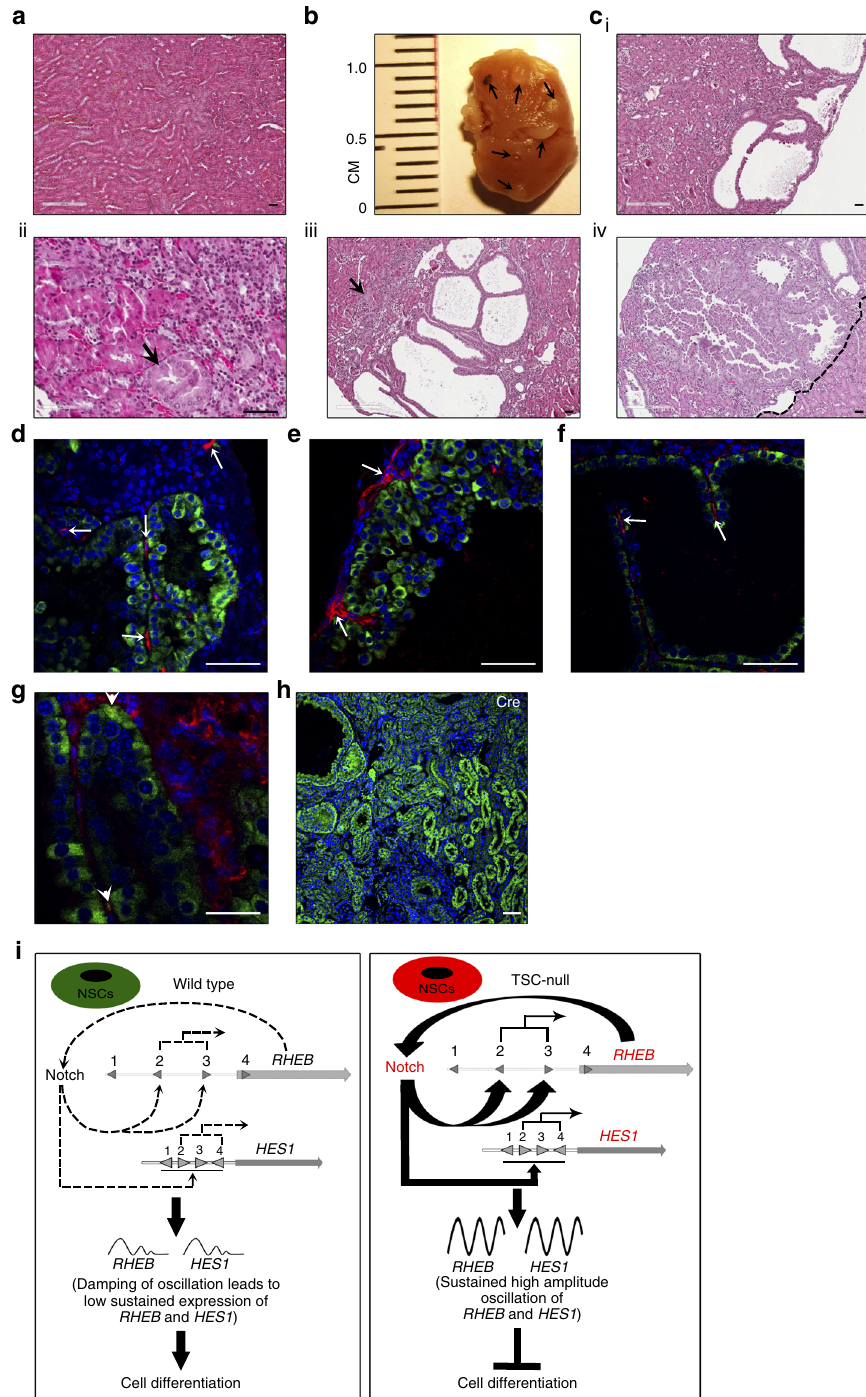
Fig. 7 Spontaneous renal tumorigenesis induced by cell-type-speci fi c loss of Tsc1 . a H&Es of Tsc1 f/f (control) kidney, n = 3. b Kidney lesions in Nestin- TamCre;Tsc1 f/f ; c H&Es of Nestin-TamCre;Tsc1 f/f kidneys, n = 3: (i) cysts; (ii) RIN (arrow); (iii) papillary carcinoma (micro-invasion-arrow); (iv) invasive papillary renal cell carcinoma (dashed line indicates border between RCC and normal kidney). Tamoxifen was injected intraperitoneally into 2 – 3-month-old mice at the dose of 120 mg/kg/day for two consecutive days. Mice were harvested at the age of 7 months. d – f Expression of nestin (red) in renal spindle- shape tumor cells. Expression of phospho-S6 within renal lesions (green). g Co-expression of nestin and phospho-S6 in spindle-shape tumor cells (arrowheads). h Expression of Cre recombinase within renal lesions of Nestin-TamCre;Tsc1 f/f mice. i The role of the Rheb-Notch-Rheb loop during NSC maintenance. The loss of Tsc1 blocks the differentiation of NSCs and progenitors via activation of the Rheb-Notch-Rheb loop, which leads to the ampli fi ed oscillation of HES1 and RHEB , controlled by the fl uctuation in the binding of N1ICD to their activating